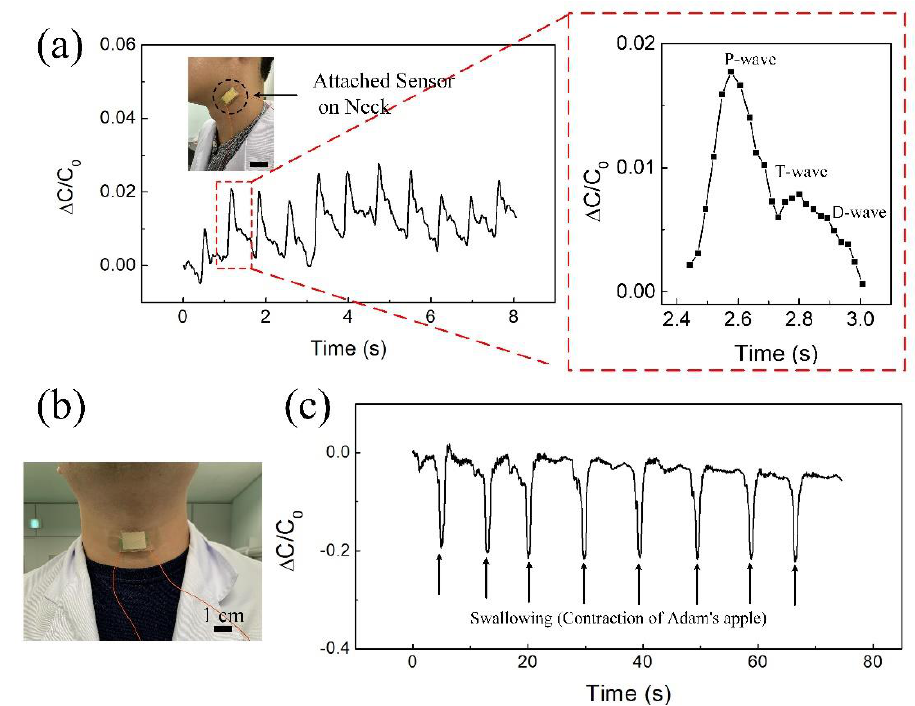
Figure 7. Applications of the pressure sensor to health monitoring. ( a ) Capacitance response of the pressure sensor on the neck. ( b ) Photos of sensor attached to the Adam’s apple. ( c ) Sensing performance of the sensor attached on Adam’s apple by contraction.